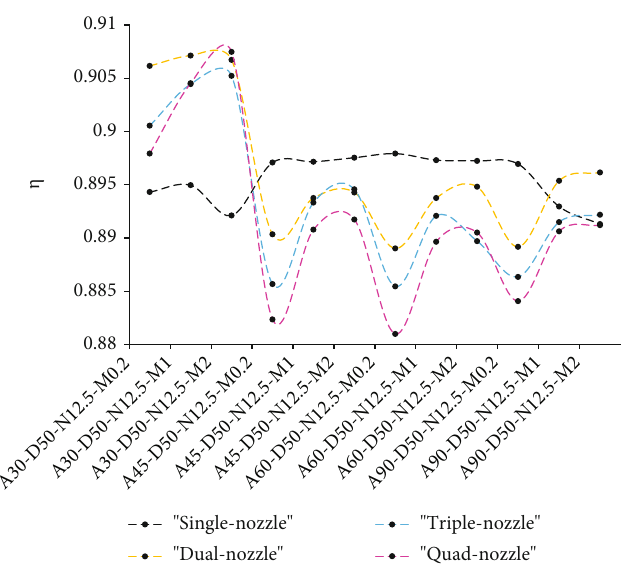
Figure 9: Witte-Shamsundar e ffi ciency ( η